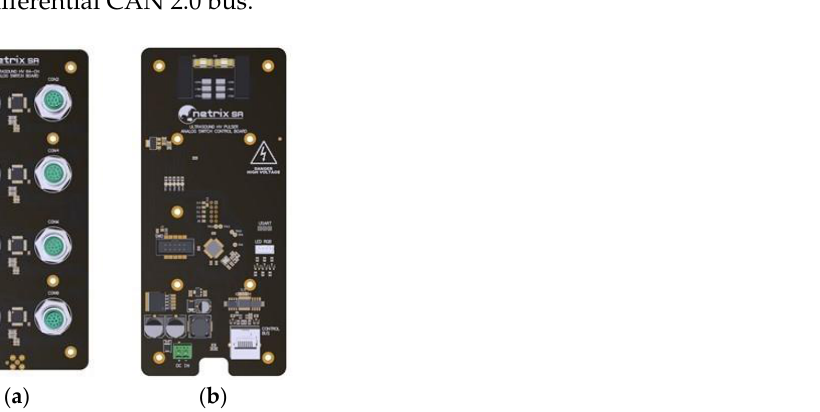
Figure 4. The experimental setup. The circular tank with 16 transducers and a cylinder phantom placed in its centre is filled with water during experimentation.